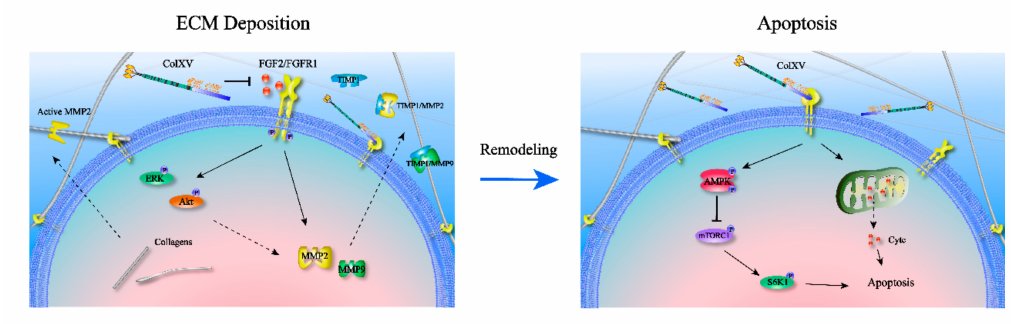
Figure 9. Graphical Abstract: ColXV aggravated apoptosis in mice white adipocytes by facilitating abnormal extracellular matrix